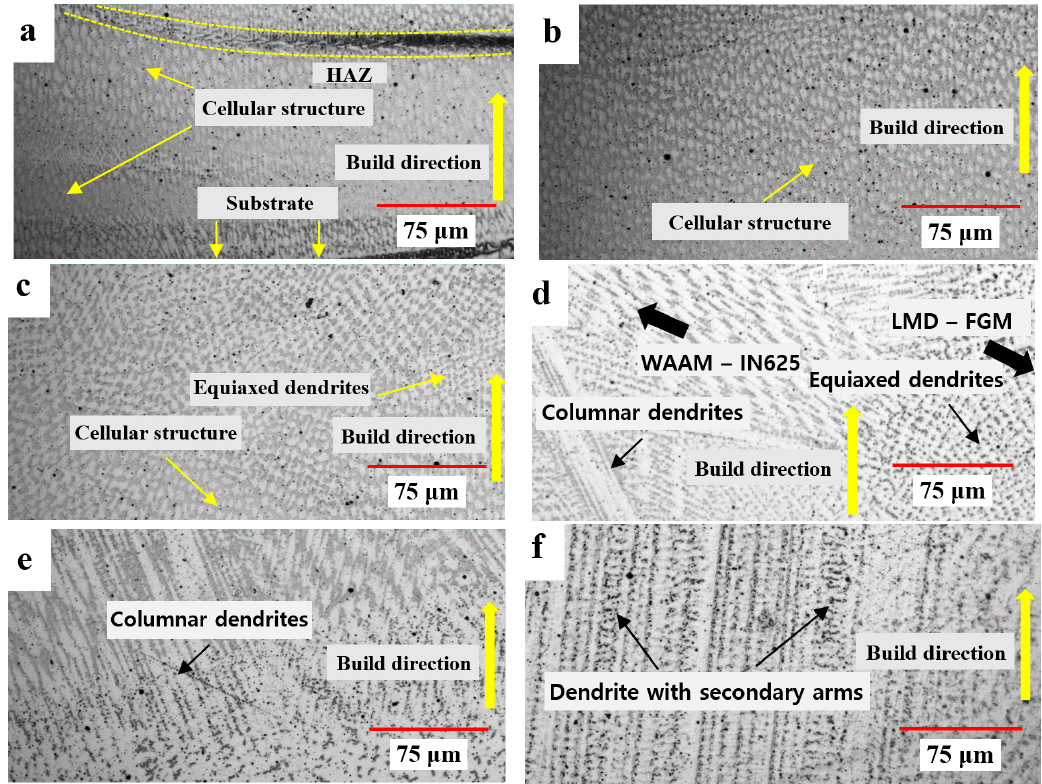
Figure 6. Microstructure of the LMD-WAAM sample (800 W): ( a ) The bottom region of the FGM layer; ( b ) the middle region of the FGM layer; ( c ) the upper region of the FGM layer; ( d ) the bottom region of the WAAM layer; ( e ) the middle region of the WAAM layer; and ( f ) the upper region of the WAAM layer.